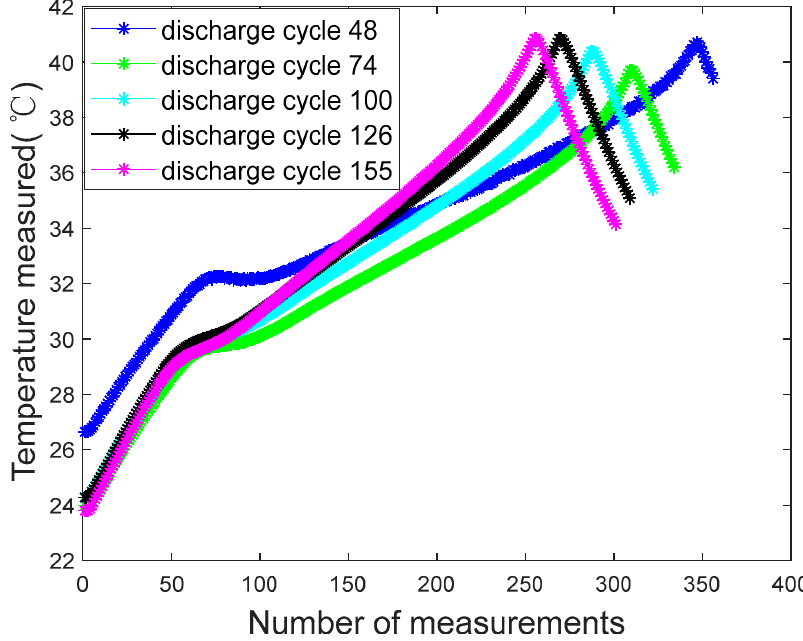
Figure 3. the battery temperature process change during the discharge cycle.